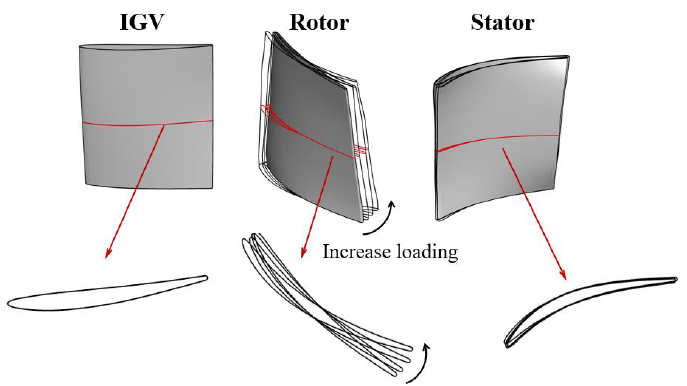
Figure 8. Geometric configuration of the four compressor stages.